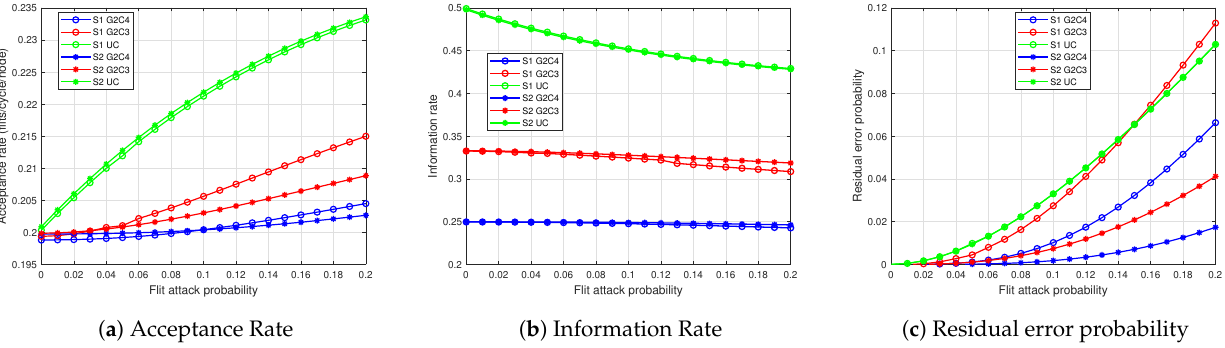
Figure A2. Simulation results for 8 × 8 2D mesh in scenario no modification, i.e., p a = p d .